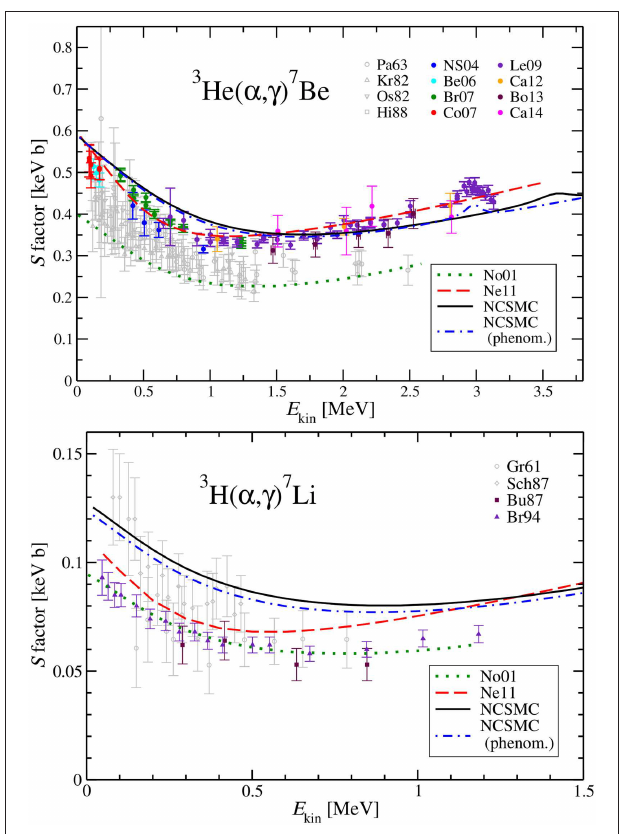
FIGURE 3 | 3 He( α , γ ) 7 Be and 3 H( α , γ ) 7 Li S -factors computed with the No Core Shell model (solid lines). The other lines represent alternative calculations (see Dohet-Eraly et al., 2016 for details and for the references to the data). Reprinted from Dohet-Eraly et al. (2016) with permission from Elsevier.